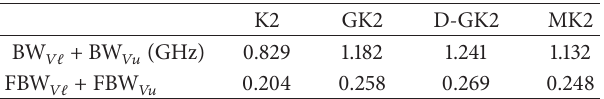
Table 5: Aggregate absolute and fractional bandwidths achieved by the four proposed dual-band